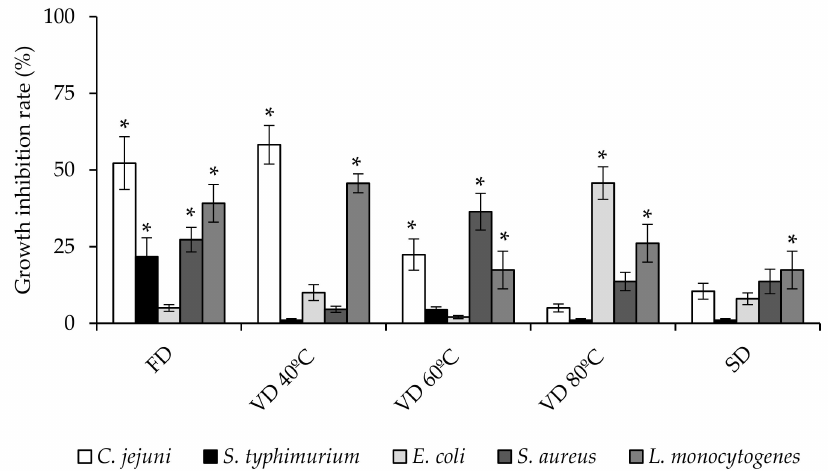
Figure 1. E ff ect of PEP (1 mg / mL) on foodborne bacteria growth after 24 h of incubation. Results represent the percentage of growth inhibition respect to the untreated control (100% of growth) and are expressed as mean ± SD ( n = 3). Bars marked with asterisk indicate significant growth inhibition respect to the control by t -test ( p ≤ 0.05). Freeze drying (FD); Vacuum drying 40 ◦ C (VD 40 ◦ C), 60 ◦ C (VD 60 ◦ C), 80 ◦ C (VD 80 ◦ C); Spray drying